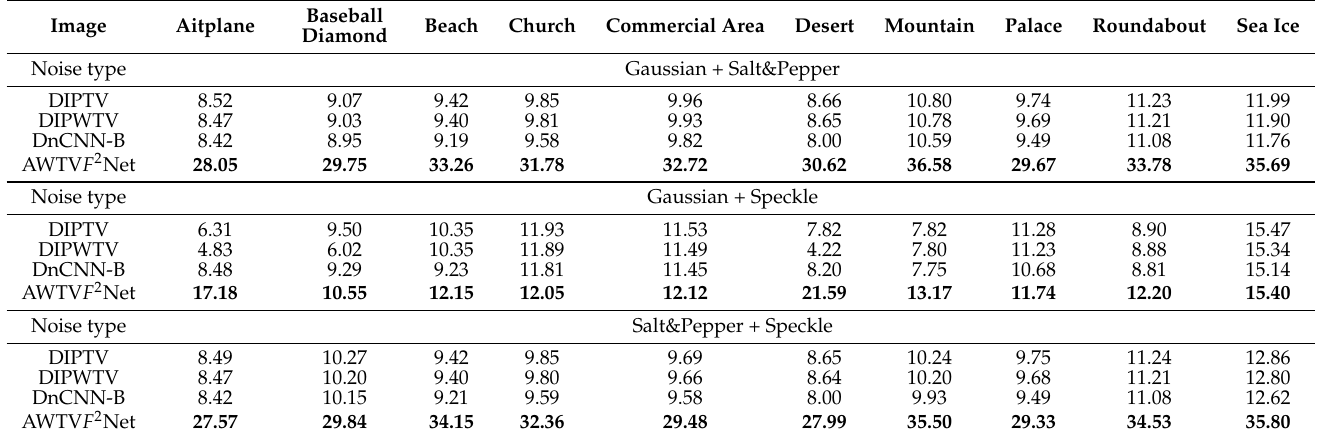
Table 6. PSNR comparisons of each class in the NWPU dataset with various types of mixture noise. The bold values denote the best results.